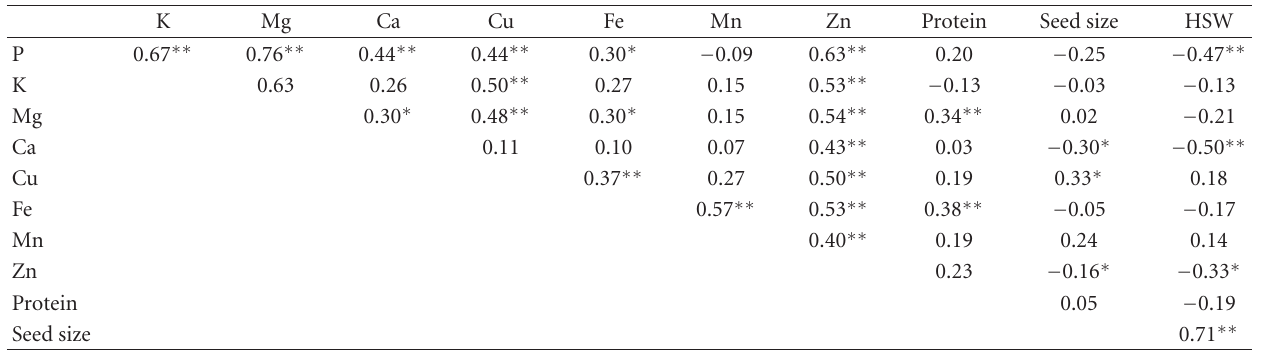
Table 3: Correlation coe ffi cients between seed macro- and microelement concentrations among lentil landraces and cultivars.